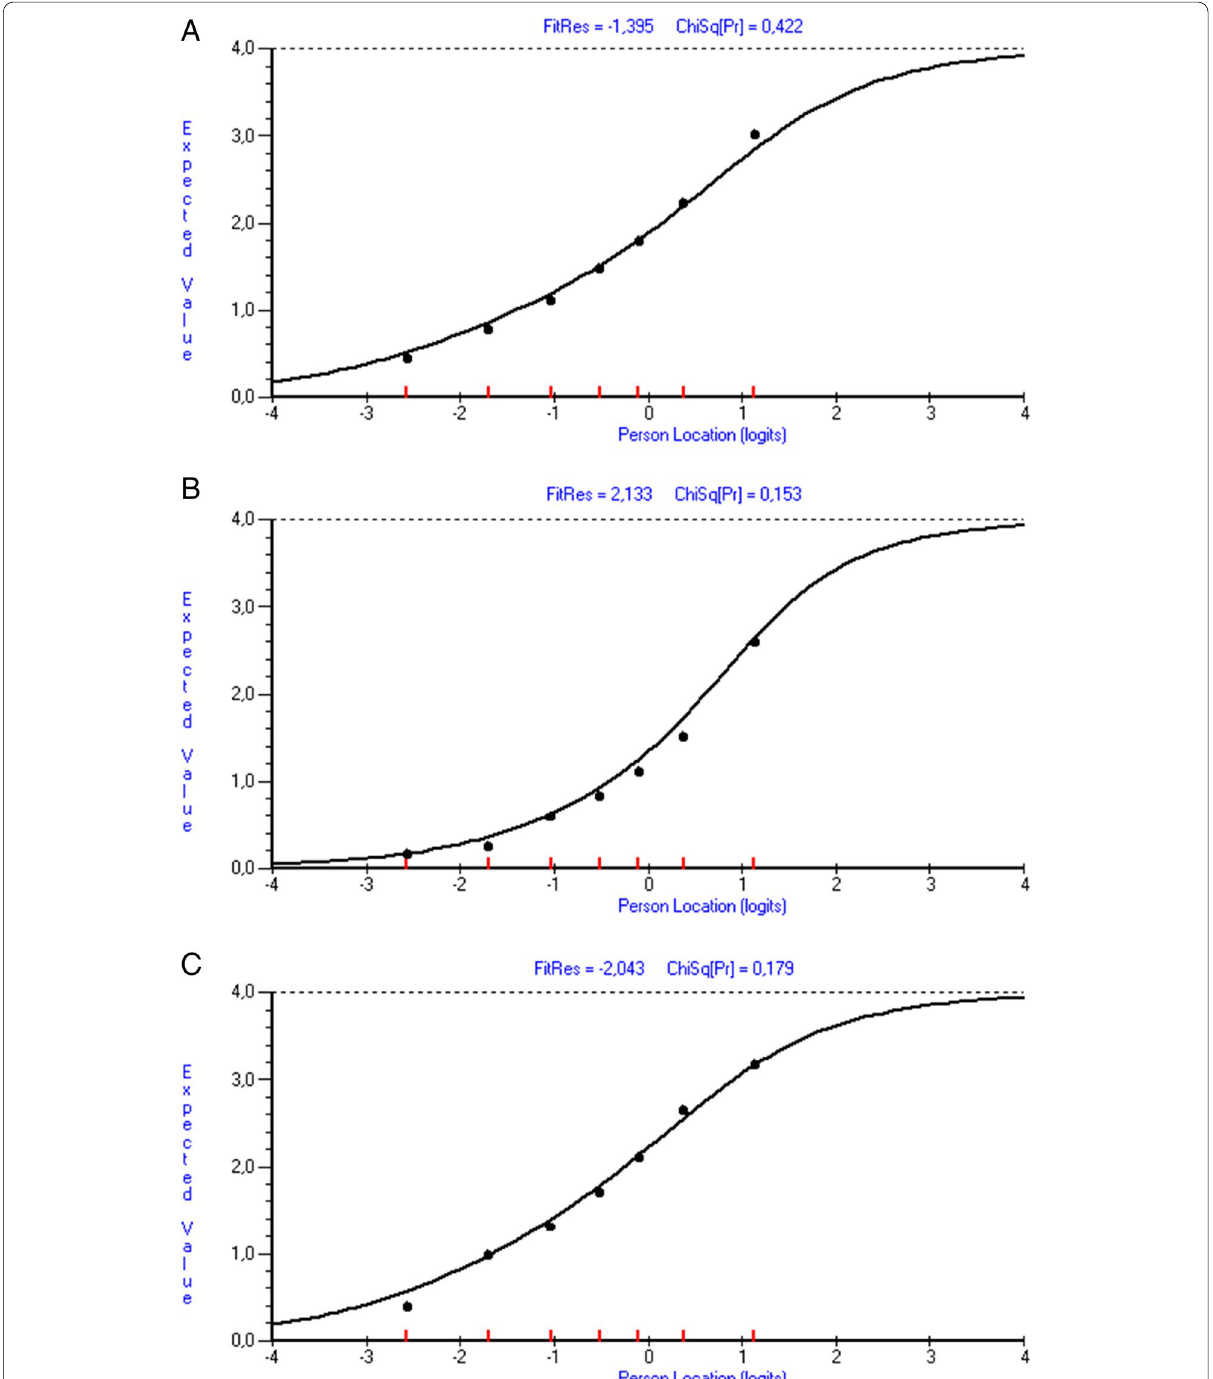
Fig. 3 ICCs representing the Minimal Insomnia Symptom Scale‑Revised item 1 (‘difficulties falling asleep’; Panel A ), item 2 (‘night awakenings’; Panel B ), item 4 (‘daytime disturbance’; Panel C ). ICCs represent expected item responses (y‑axis) for each person location (x‑axis) on the measured continuum. Black dots represent observed responses from groups of persons (class intervals) at similar locations on the measured continuum